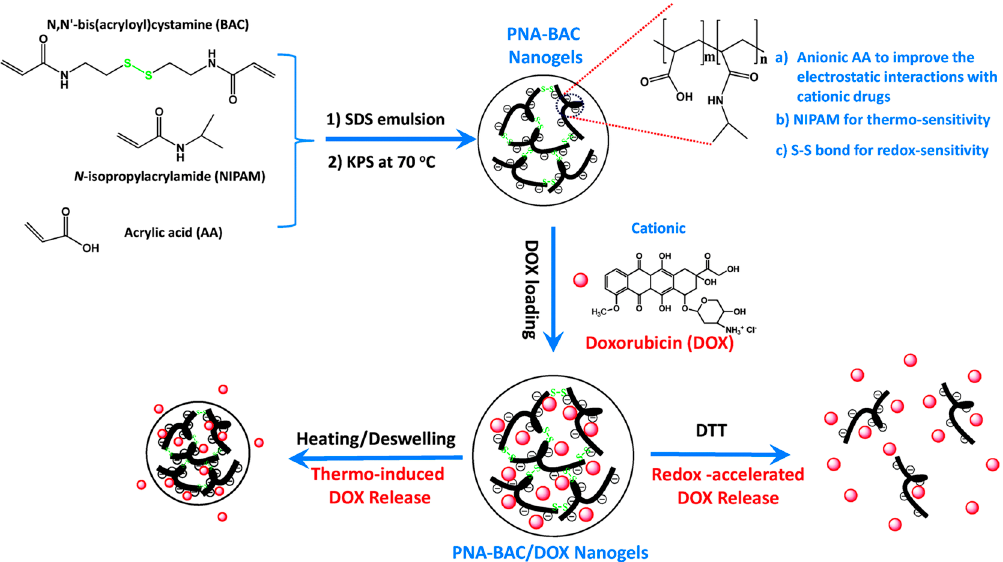
Figure 11. Scheme of preparation of PNA-BAC/DOX nanogels for in vitro anticancer drug release, reported by Zhan et al. [102]. Reprinted with permission from reference [102]. Copyright © 2015 The Royal Society of Chemistry.